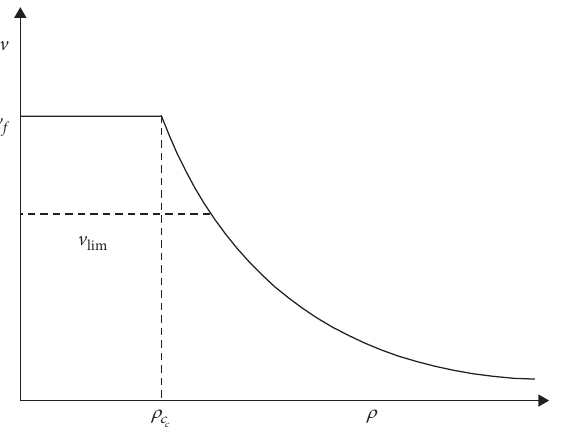
Figure 1: Speed and density relationship.